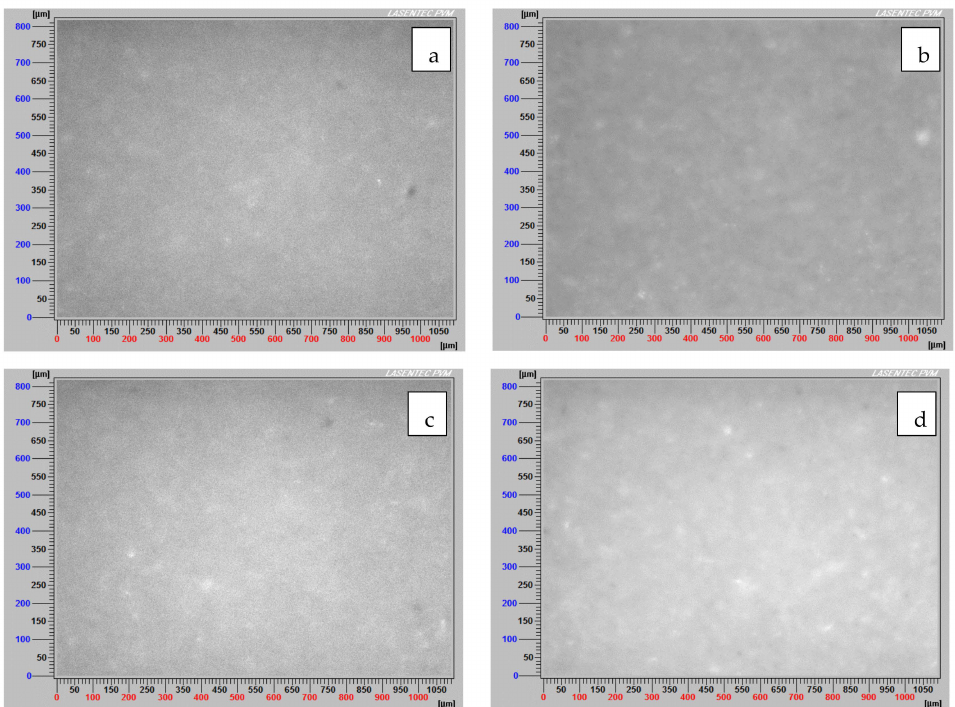
Figure 10. Images of non-flocculated tailings ( a ) KQ-SW, ( b ) KQ-IW, ( c ) MQ-SW, ( d ) MQ-IW. Mixing rate 180 rpm, solids concentration 8 wt% (10/90 clay/quartz), pH 8.